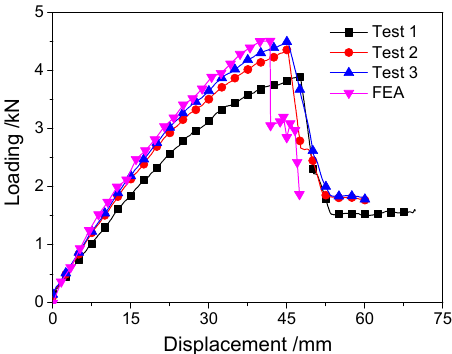
Figure 12. Comparison of simulation and test results.